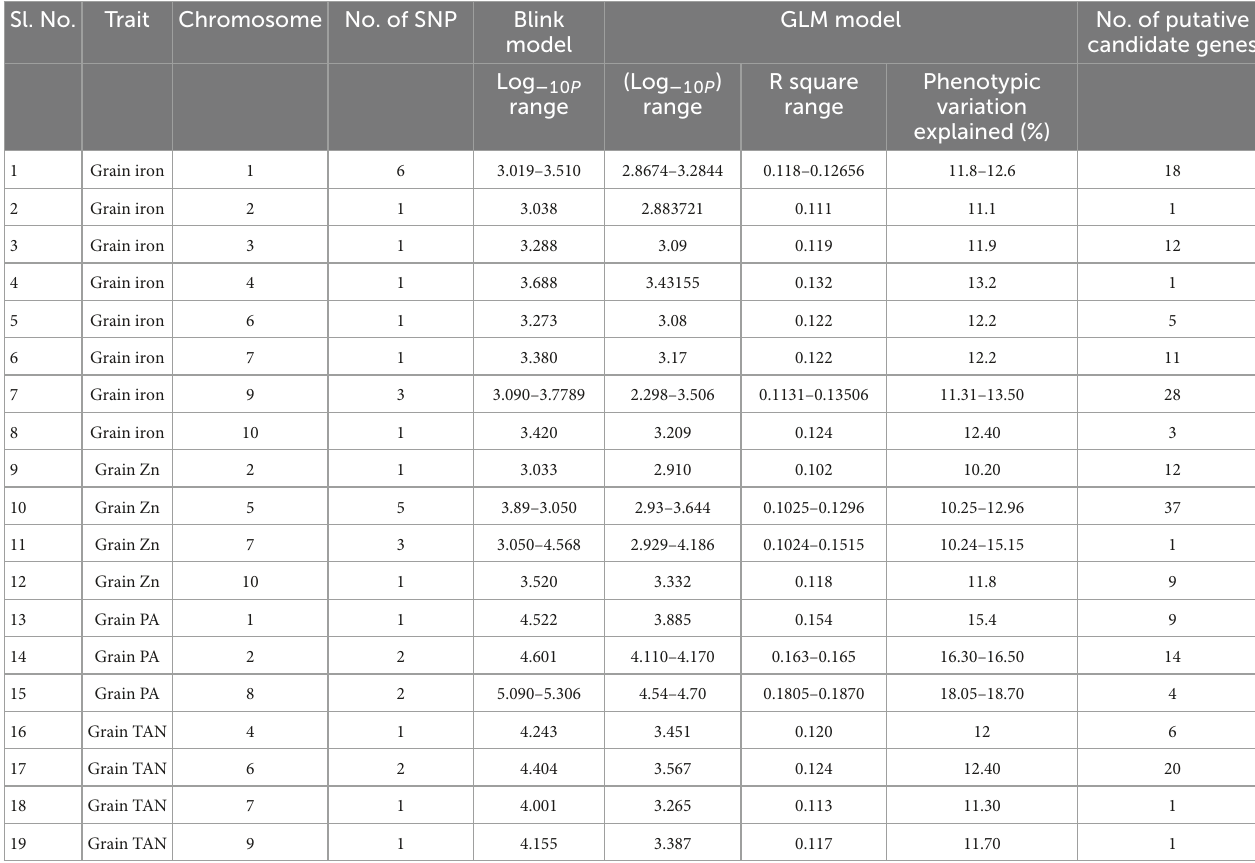
TABLE 2 Details of SNPs on different chromosomes and their corresponding putative genes associated with traits studied. Sl.